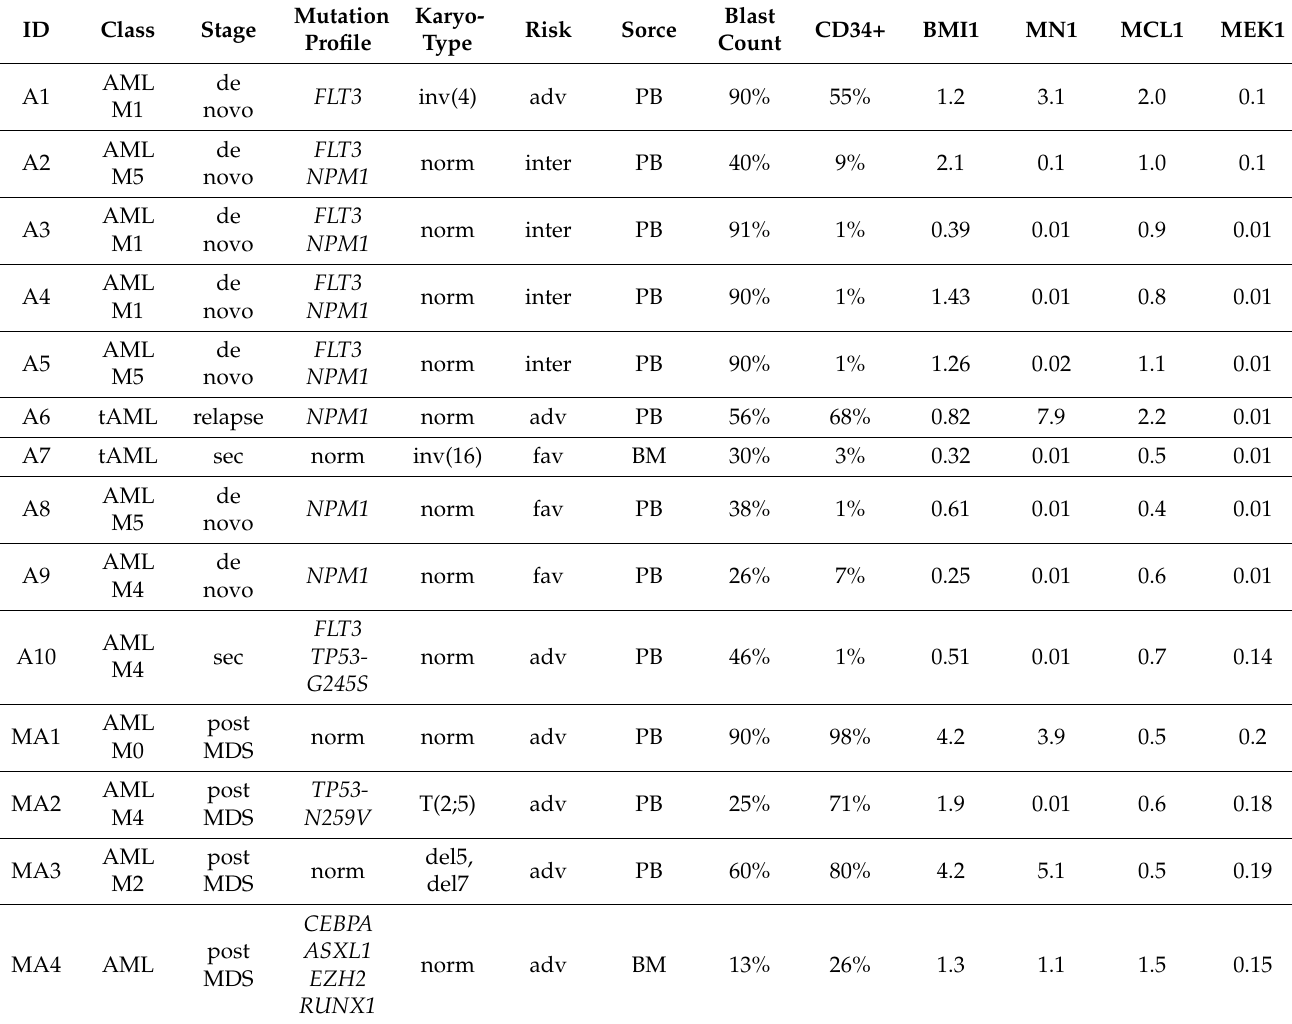
Table 3. Clinical characteristics, gene expression, and protein levels in the hematological